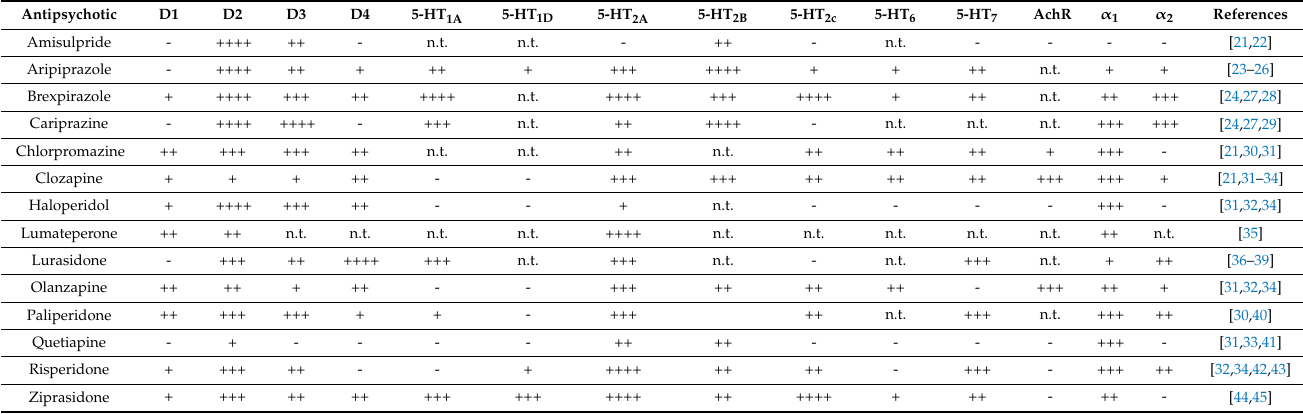
Table 1. Receptors’ affinity profile of antipsychotic drugs.